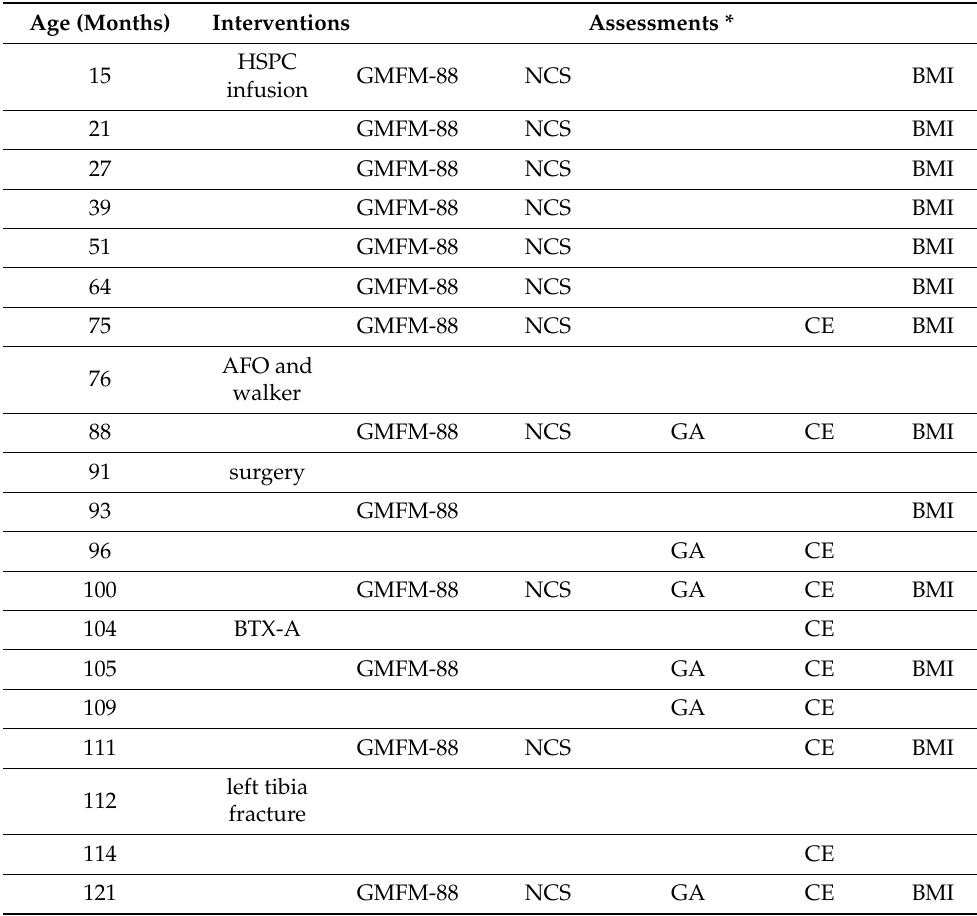
Table 1. Timeline of assessments and